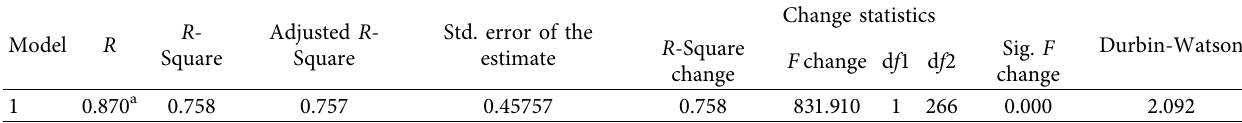
Table 6: Model summary part (a).